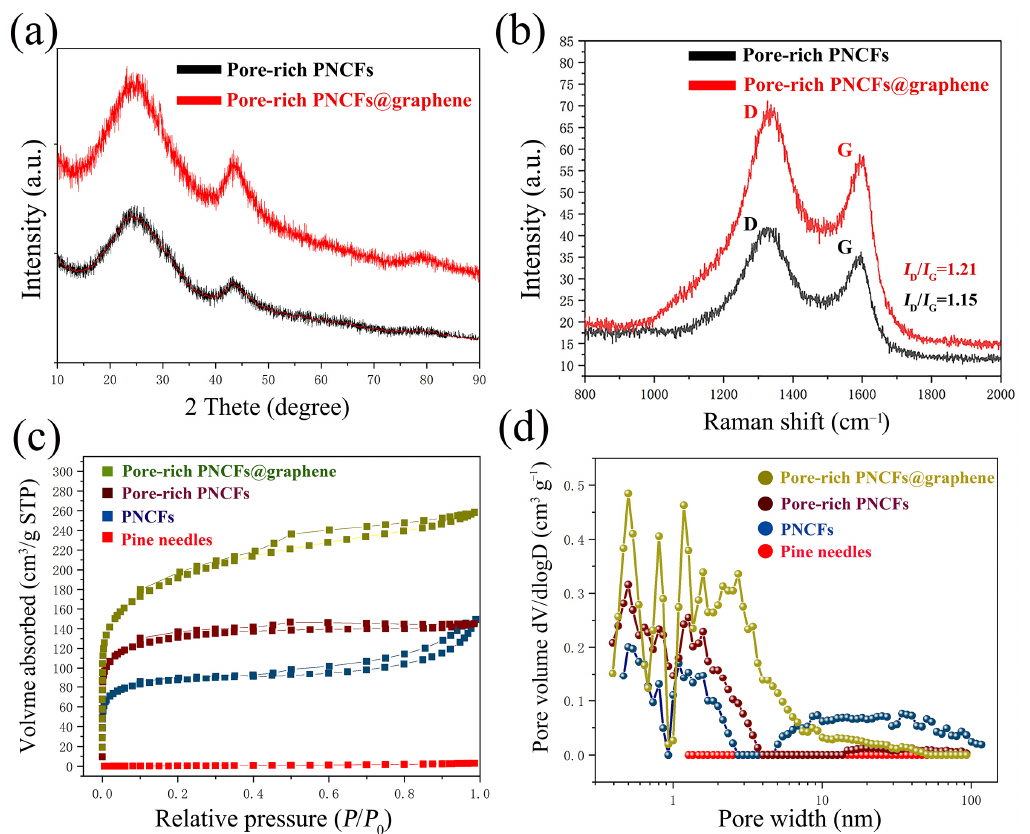
Figure 4. Analysis of the crystal structure, chemical composition, and pore structure of the pore-rich PNCFs@graphene composite: ( a ) XRD patterns; ( b ) Raman spectra; ( c ) N 2 adsorption–desorption isotherms; ( d ) DFT model incremental pore volume vs. pore width.